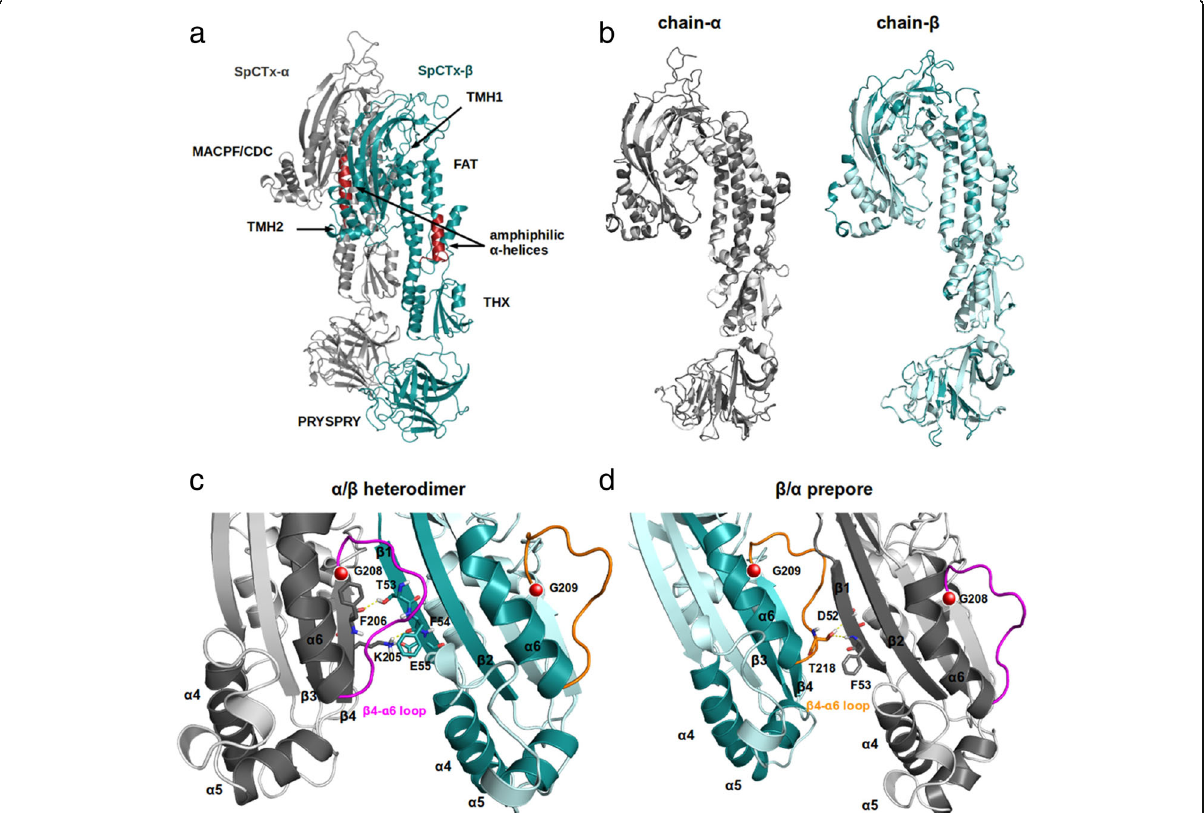
Fig. 5 Three-dimensional modeled structure of Sp-CTx. The Sp-CTX modeled structures are shown in cartoon format. a Modeled structure showing interactions between Sp-CTx subunits; Sp-CTx- α (gray) and Sp-CTx- β (blue). Identification of the N-terminal domains; MACPF/CDC, FAT, THX and PRYSPRY, the transmembrane α -helices TMH1 and TMH2, the amphiphilic α -helices (red) of Sp-CTx- α and β -chains. b The structure of Sp-CTx aligned with SNTX (Protein Data Bank ID code 4WVM) and schematic representation of α -subunits (gray) on the left and β -subunits (blue) on the right. Lighter tones depict the structure of SNTX. c Highlighted interface region within the heterodimer in the MACPF/CDC with β -strands numbered according to their position in the central β -sheet. The β 4- α 6 loop is shown in pink, the conserved G208 (Sp-CTx- α ) is shown as a red sphere. Hydrogen bonds between the residues F206 and K207 of strand- β 4 (Sp-CTx- α ) and T53, F54, E55 of strand- β 1 (Sp-CTx- β ) are displayed as yellow dashed lines. d The interface region of prepore in MACPF/CDC. The β 4- α 6 loop is colored orange, the conserved G209 (Sp-CTx- β ) is shown as a red sphere. Hydrogen bonds between residues T218 in β 4- α 6 loop (Sp-CTx- β ) and D52, T53 of strand- β 1 (Sp-CTx- α ) are shown as yellow dashed lines. Figures were generated using Pymol (v1.7.0.0), (http://www.pymol.org/; Delano Scientific LLC, South San Francisco,